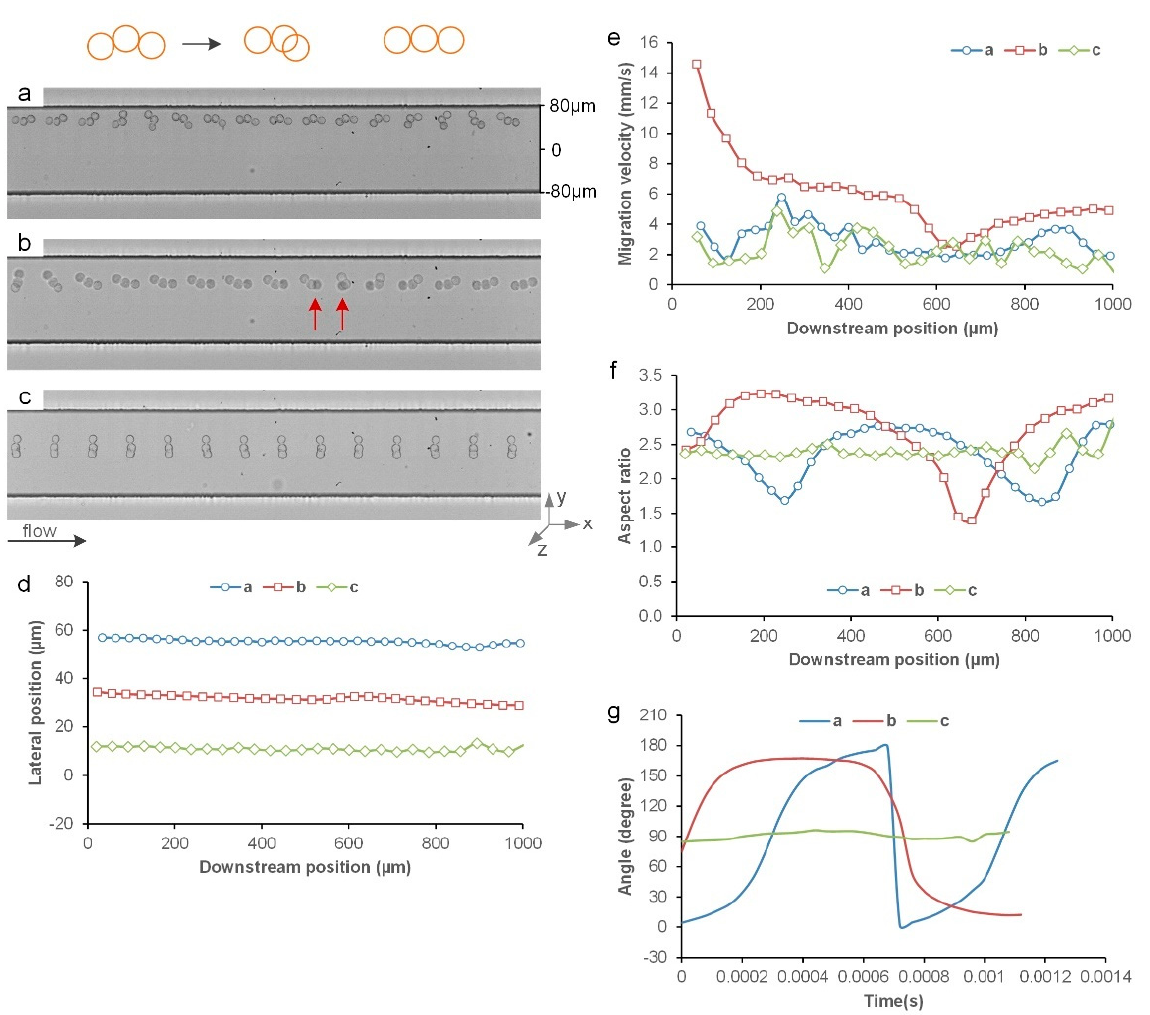
Figure 3. Inertial migration of string triplets: ( a ) A string triplet near channel sidewall slowly migrates away from the wall while rotating about the z -axis; ( b ) A string triplet away from the wall slowly migrate toward the channel centerline while folding the cell on its one end. Red arrows indicate the changing of the cell arrangement; ( c ) A string triplet close to the channel centerline is rolling downstream (rotating about y -axis) aligning in the direction of channel width ( y -axis); ( d – g ) The lateral displacement, lateral migration velocity, aspect ratio, and rotation of the three doublets in ( a – c ). Note that the rotation of the triplet about the y -axis was not captured in the green curve in ( g ). The bright-field images in ( a – c ) are stacked every two frames to show the trajectories of the cells.